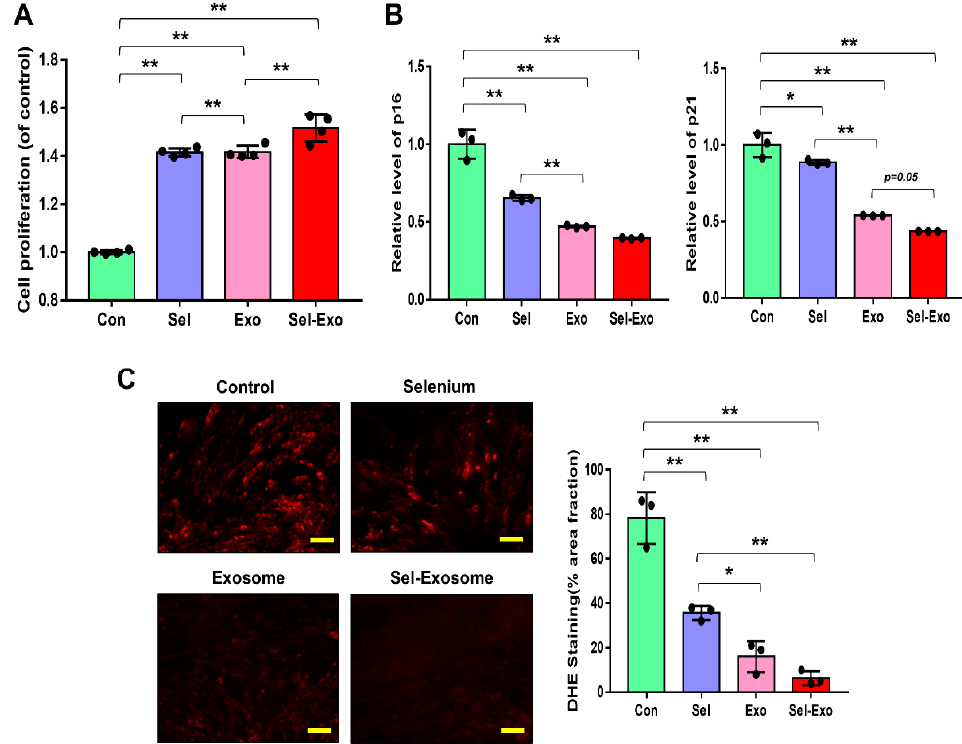
Figure 3. Proliferation activity of AdMSCs treated with selenium, exosomes, and selenium-treated exosomes. ( A ) The proliferation rates were determined after exposure to selenium, exosomes, and selenium-treated exosomes. ( B ) The mRNA expression levels of senescence-related p16 and p21 were evaluated by real-time PCR. ( C ) ROS levels were determined by dihydroethidium (DHE) staining using fluorescence microscopy (scale bar = 100 µ m). A representative image of three independent experiments is shown. Data are expressed as the mean ± SD of three independent experiments. * Significant difference from control, p < 0.05. ** Significant difference from control, p < 0.01.